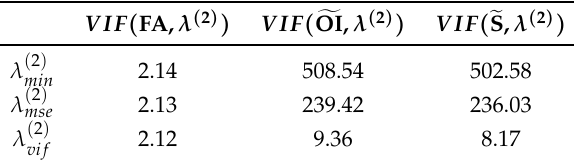
( 2 ) ( 2 ) ( 2 ) , λ mse , and λ min vif